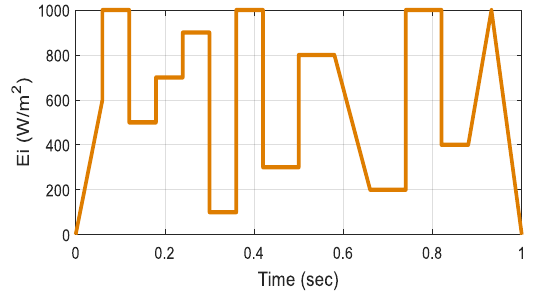
Figure 12. Variable irradiance signal used for tests.